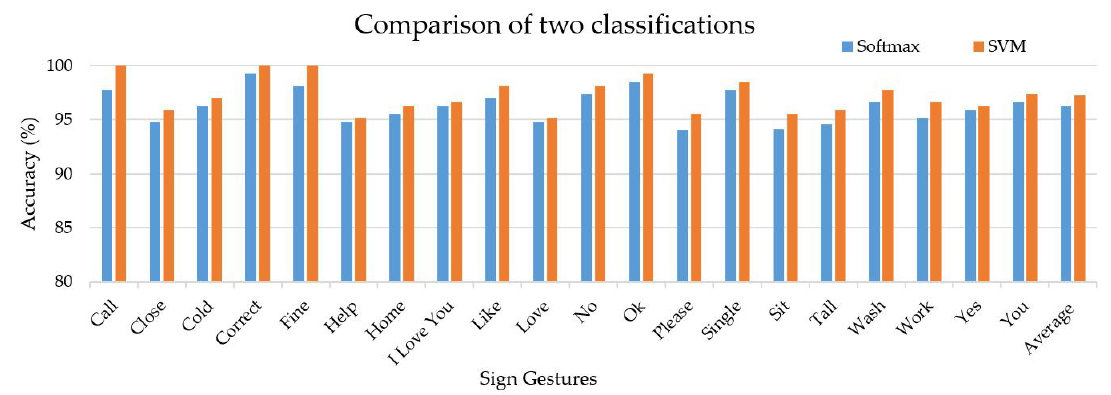
Figure 14. Performance evaluation of the two classifications, softmax and SVM.